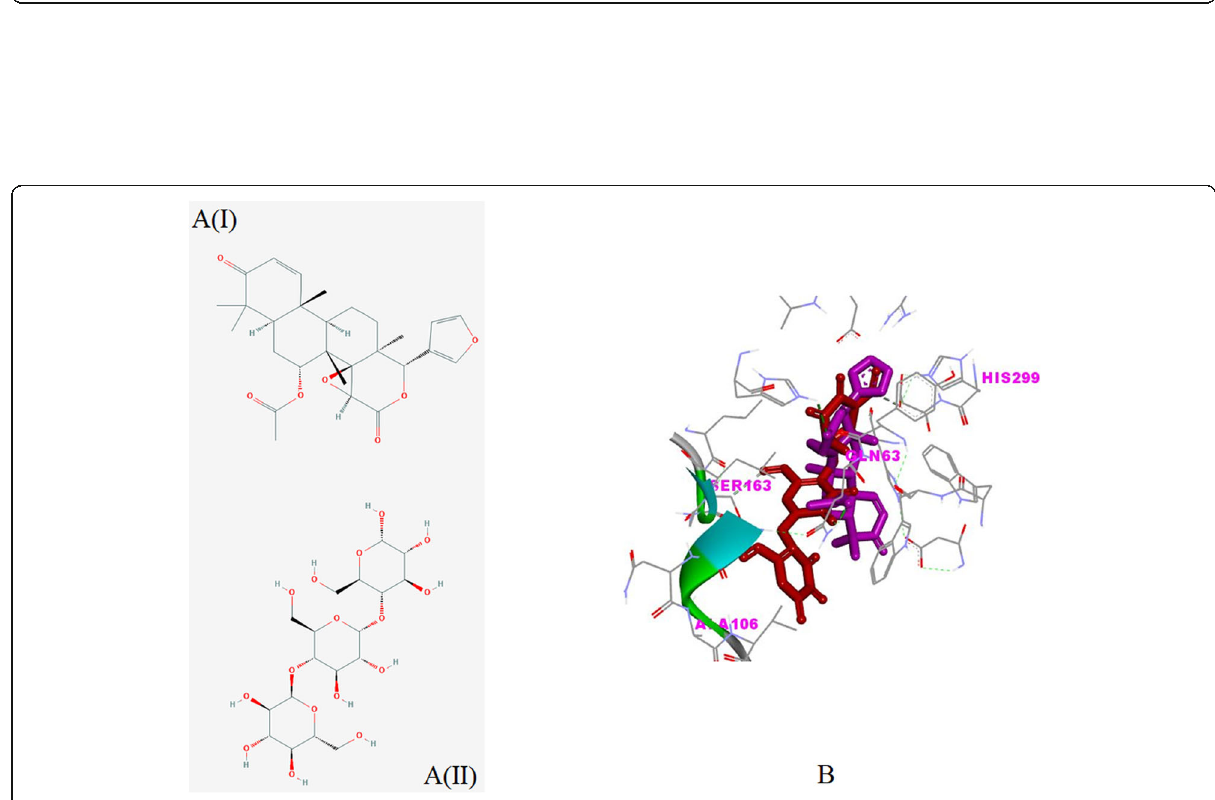
Fig. 5 Molecular docking simultaneous interaction pattern of amylose and gedunin with the active site of HSA (PDB ID: 1SMD) generated using AutoDock Tools 4.2 platform [ A(I) ] 2D structure of gedunin (PubChem CID: 12004512) [ A (II) ] 2D structure of amylose (PubChem CID: 192826) ( B ) 3D docking representation of simultaneously docked compounds (amylose- substrate in red and gedunin- inhibitor in magenta) in the binding pocket showing the hydrogen bond